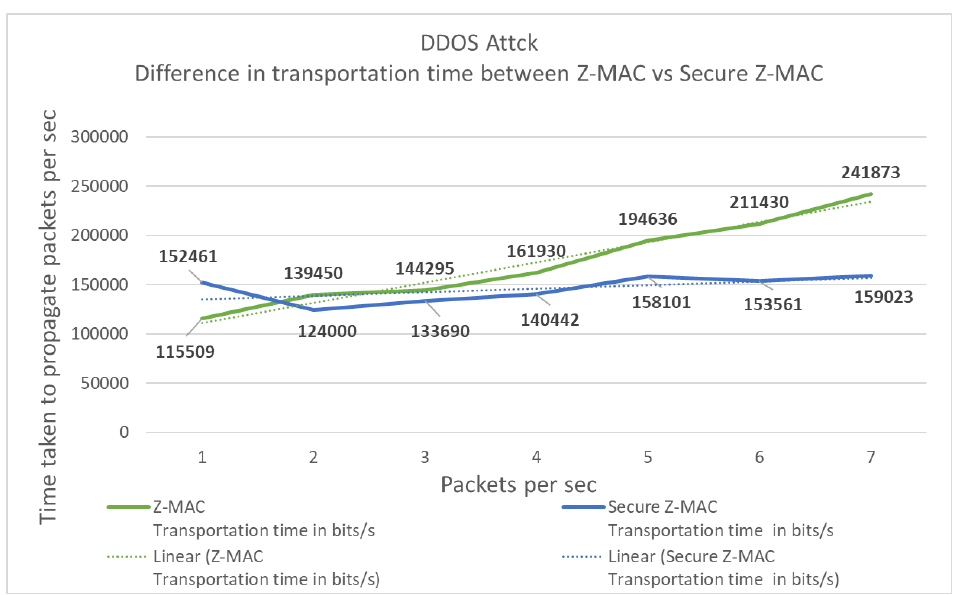
Figure 13. Graph simulating the transmission time during a DDOS attack against the packets transmitted in byte format in the secure Z-MAC scheme compared to Z-MAC.